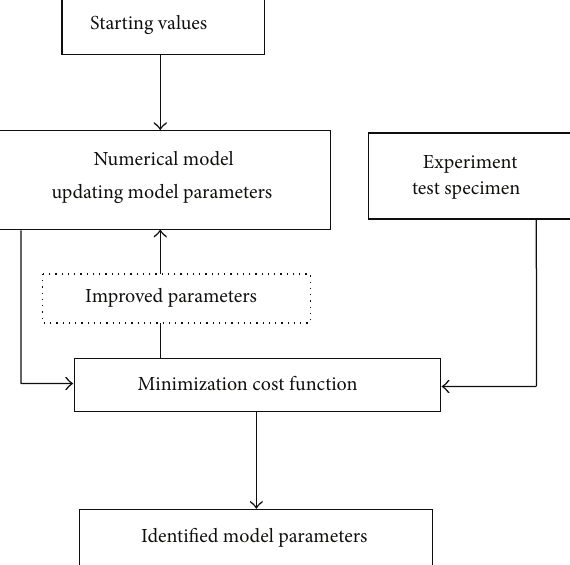
Figure 1: General flowchart of a FEM-updating